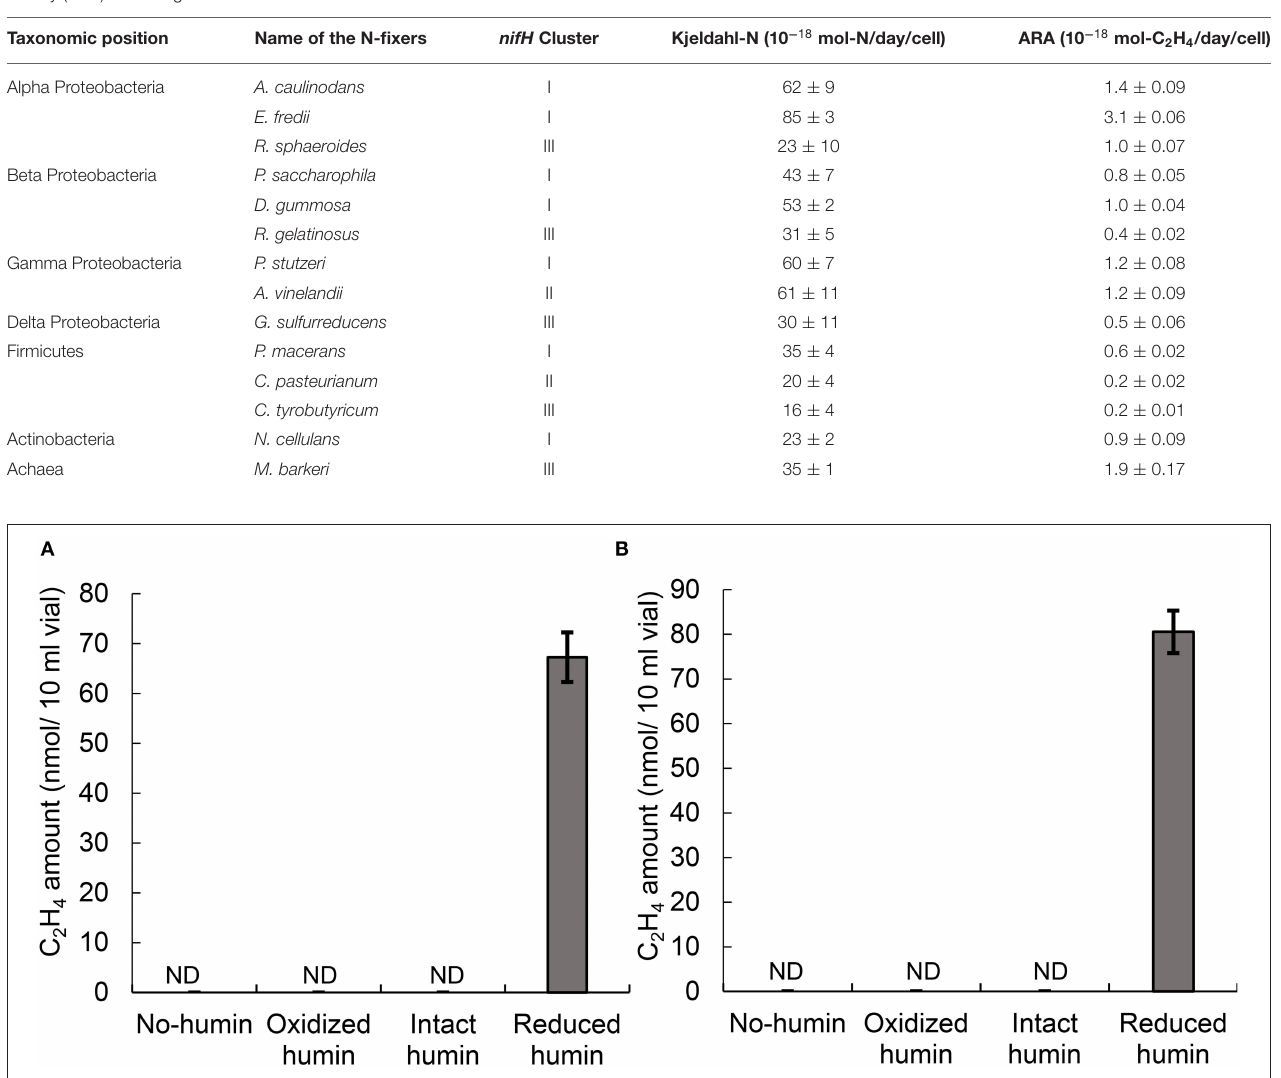
FIGURE 2 | ARA, as the amount of ethylene produced, of C. pasteurianum (A) and A. vinelandii (B) with different redox states of humin under vanadium conditions after seven days of incubation. No organic carbon source was added to the culture medium. No ARA was detected on day 0 (data not shown). Controls without inoculation did not show any ARA on days 0 and 7 (data not shown). ND, not